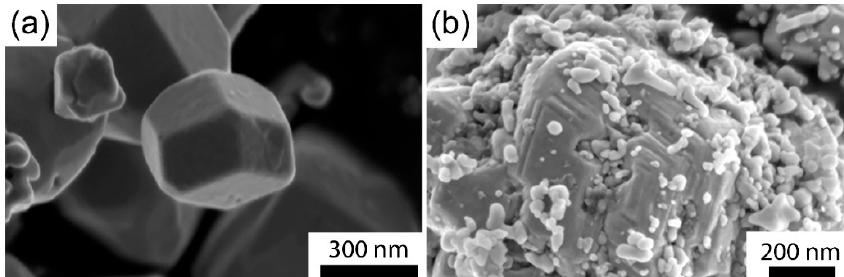
Figure 11. SEM micrographs of ( a ) tungsten powder and ( b ) scandia-doped tungsten powder. Both images were recorded in secondary electron imaging mode.